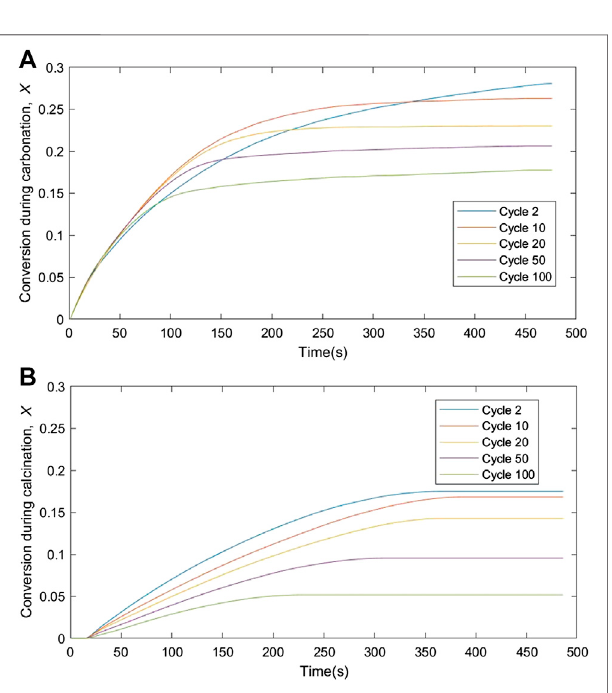
FIGURE 8 | Deconvoluted fractional solid conversion during (A) carbonation and (B) calcination over time at different carbonation-calcination cycles.